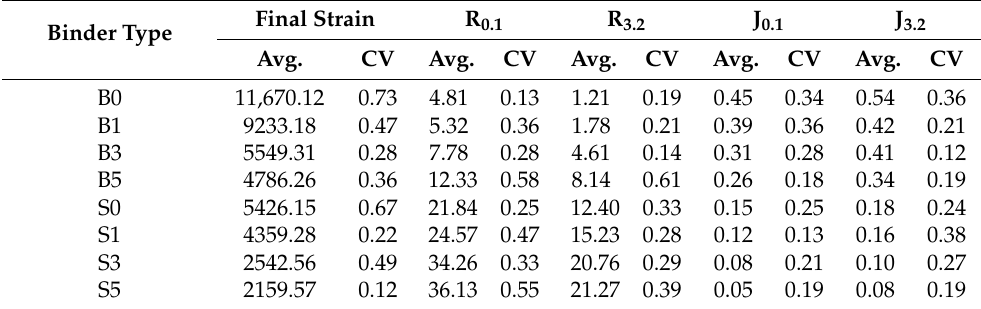
Figure 2. Final strain of asphalt binder samples. Table 6. Rheological indicators test results and coefficient of